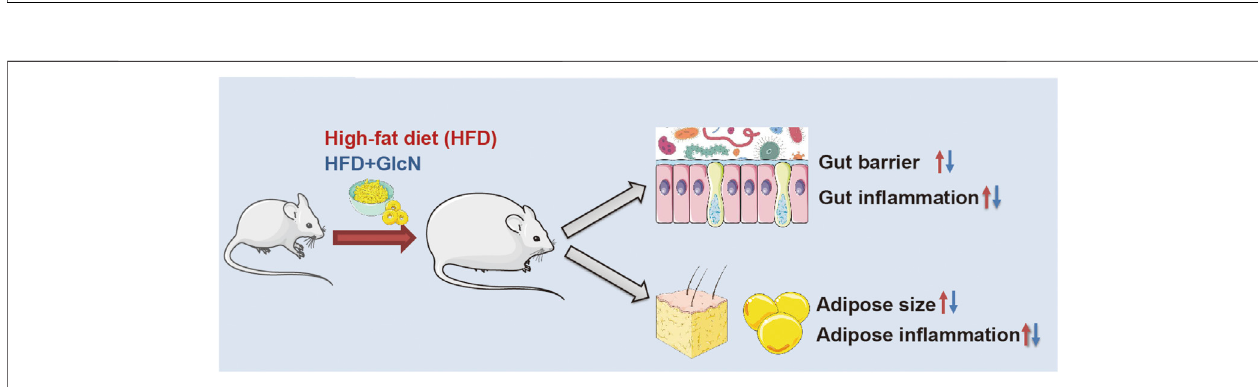
Frontiers in Pharmacology |